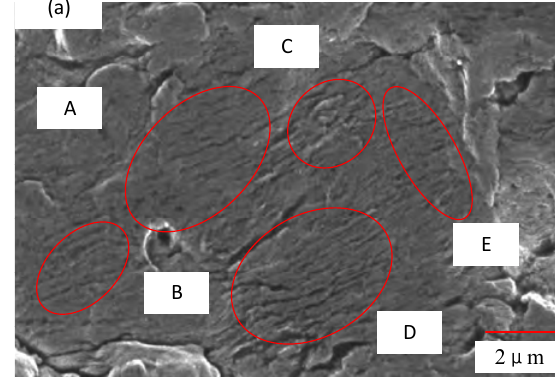
Figure 14. Fatigue crack growth.